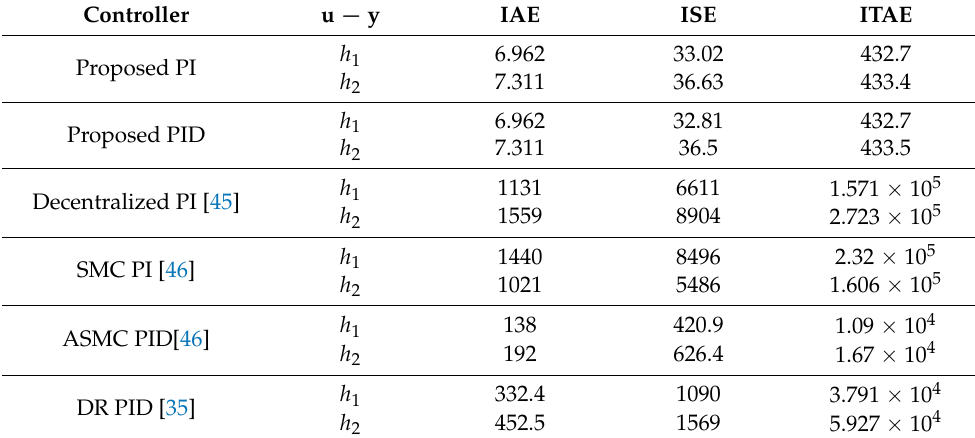
Table 3. Performance Indices: Quadruple Tank System.